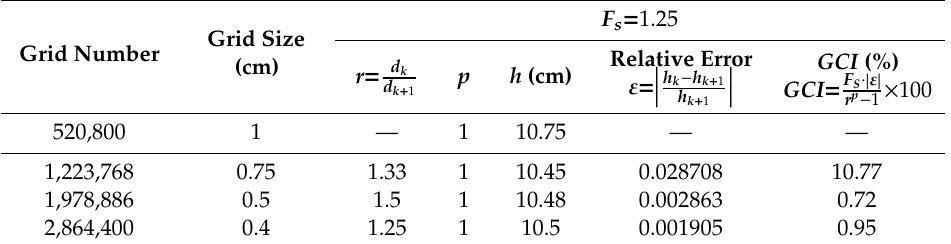
Table 2. Grid convergence index (GCI) Calculation.